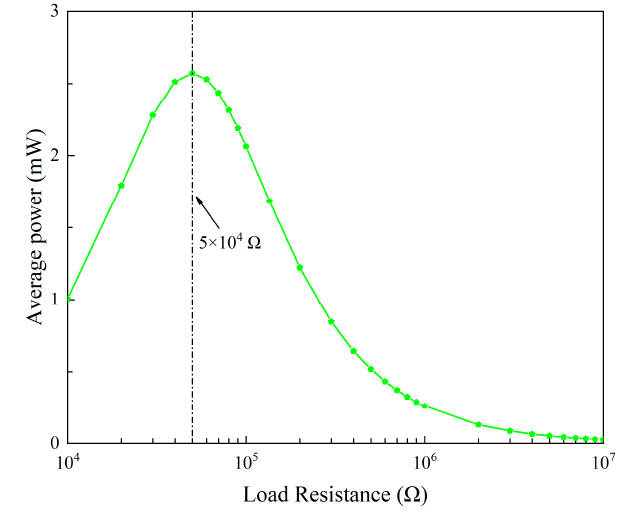
Figure 15. Average power varies with the load resistance.